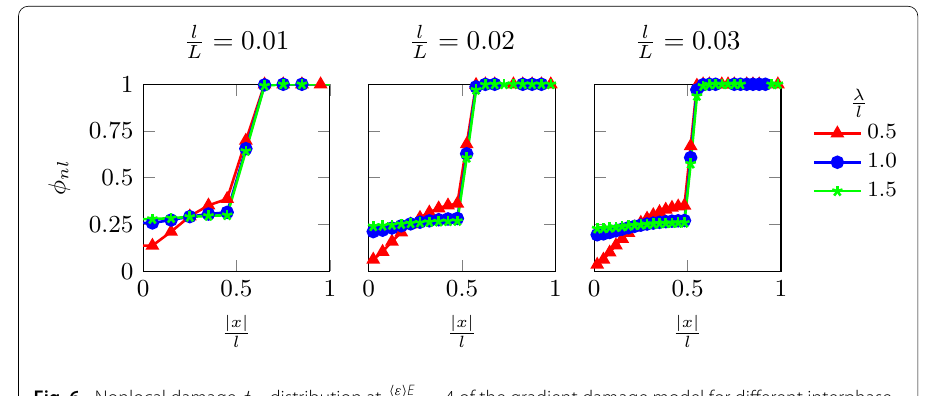
= 4 of the gradient damage model for different interphase c